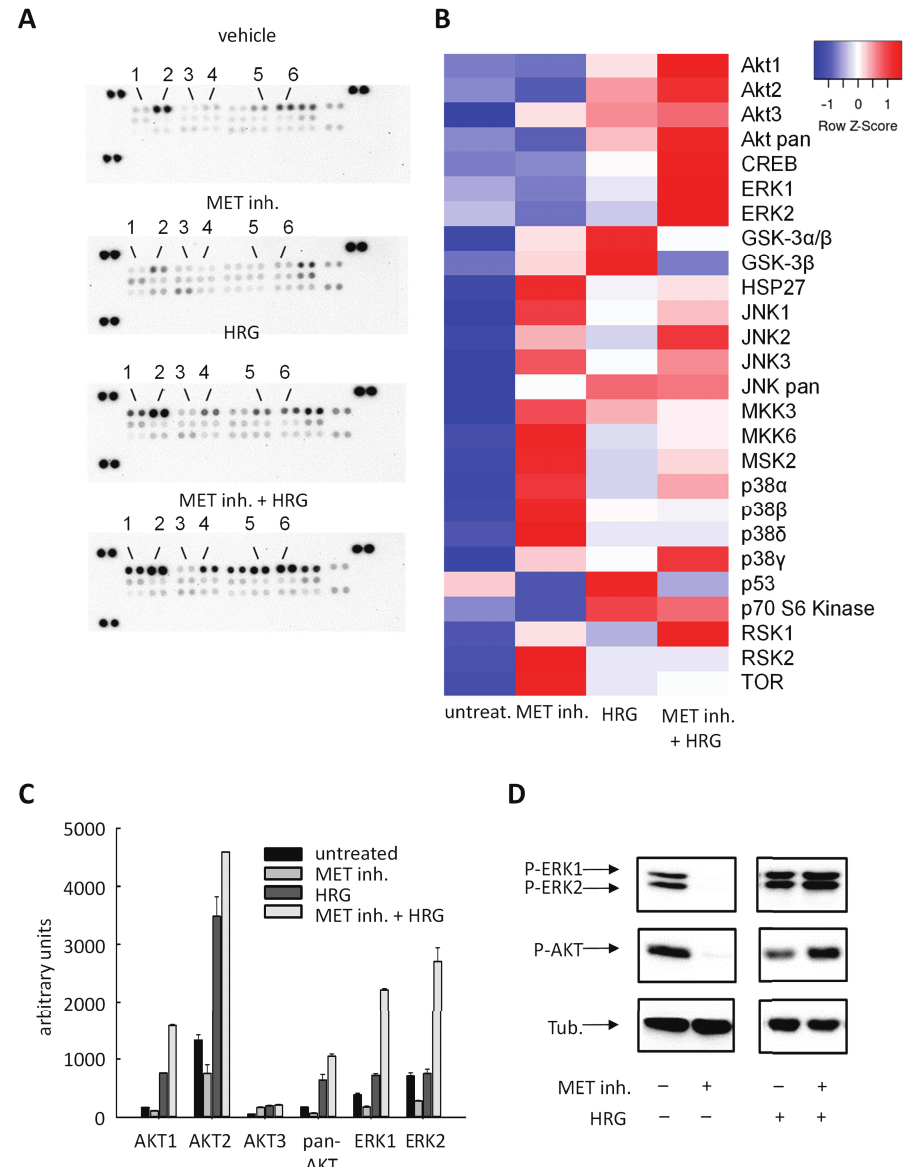
Figure 4. ( A ) Phospho-antibody arrays to elucidate downstream signal transduction effects of MET inhibition, heregulin stimulation, and the combination of both as compared to untreated (upper panel). 1, Akt1; 2, Akt2; 3, Akt3; 4, pan Akt; 5, ERK1; 6, ERK2. For the definition of all spots, see Supplementary Materials Figure S5. Cells were serum-starved for 18 h and subsequently treated with vehicle DMSO or inhibitor/HRG for 24 h. Interestingly, MET inhibition followed by HER3 stimulation via HRG showed the strongest phosphorylation levels. ( B ) Quantification of signal intensities from antibody arrays. The heat map depicts alterations upon treatment as indicated towards lower (blue) or higher signals (red). ( C ) Bar diagram showing the intensities of signaling molecules with most profound alterations. ( D ) Confirmation of alterations in ERK1/2 and Akt phosphorylation by Western blotting. Again, cells were serum-starved for 18 h and treated as indicated for 24